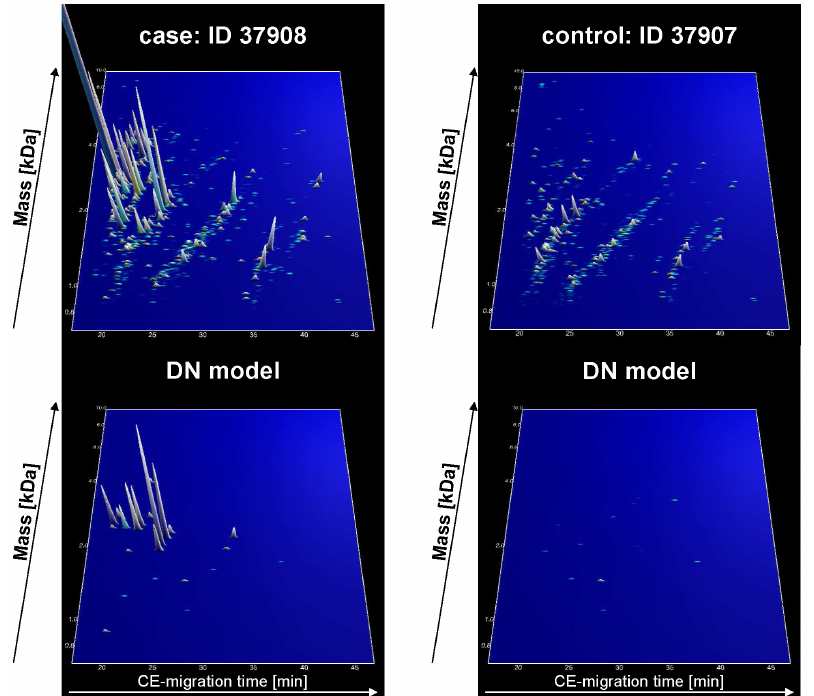
Figure 1. Polypeptide patterns of exemplarily urine samples. The upper panel shows polypeptide patterns of all peptides, which are in the urinary proteome from one patient with (ID: 37908) and one patient without DN (ID: 37907). The lower panel shows distinct peptides of the DN model of these patients urine sample. Each polypeptide is defined by its CE-migration time (x-axis, minutes), mass (y-axis, kDa), and signal intensity (z- axis). The molecular mass is indicated on the left, the normalized migration time is indicated on the bottom.